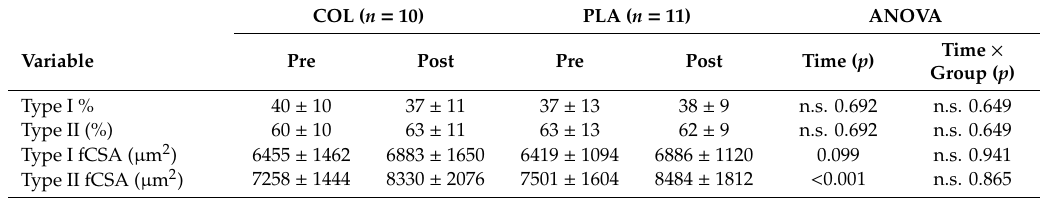
Table 2. Muscle fiber distribution (%) and muscle fiber cross-sectional area (fCSA) before (pre) and after (post) a 12-week training period with collagen peptide (COL) or placebo (PLA) supplementation. n.s. = p >